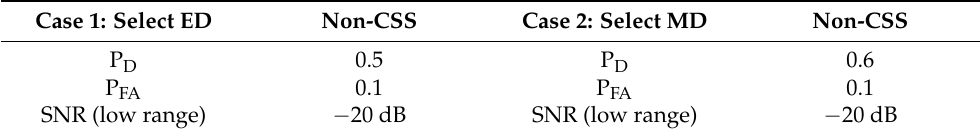
Table 2. Hybrid detector performance parameters under a non-CSS environment.